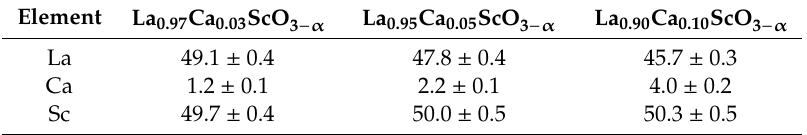
Figure 3. SEM images (BSE) of surface morphology: ( a ) With cross-sections with EDX maps (both La and Ca distribution); and ( b ) for LCS ceramic samples. Table 2. Results of EDX analysis of LCS3, LCS5, LCS10 ceramic samples (in relative at. %).